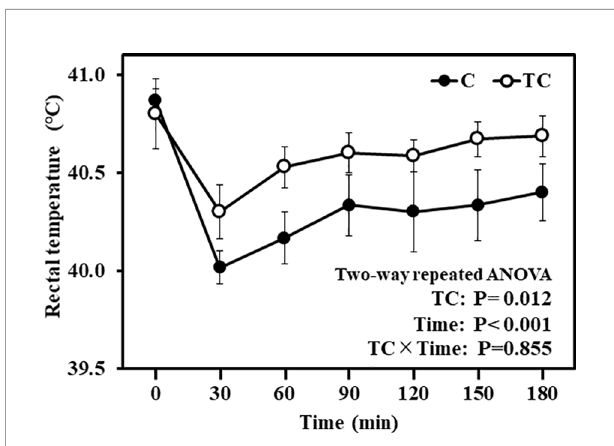
FIGURE 2 | Changes in rectal temperature during and after low temperature exposure in experiment 1. The number of chicks in each group was n = 8. C, control; TC, thermal